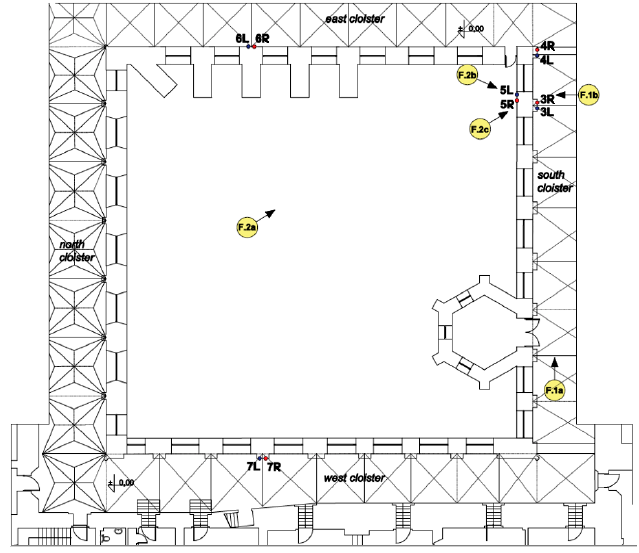
Figure 5. Floor plan of the cloisters with marked places of measurements. The presented research was carried out on stand F.1b (3R, 3L).